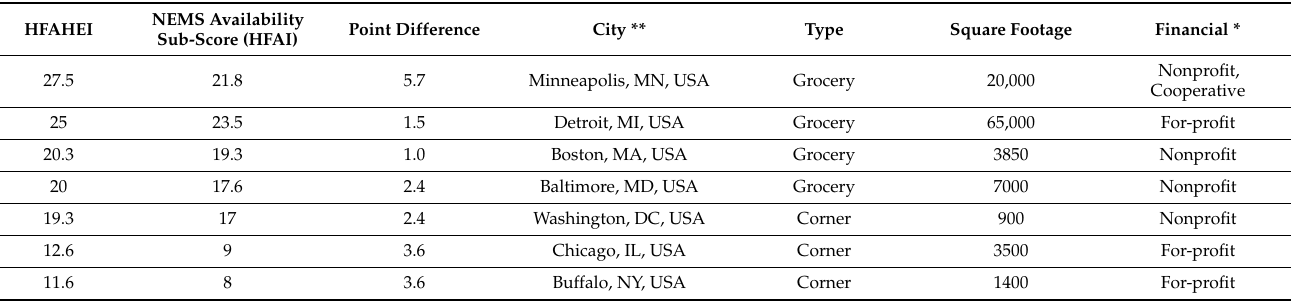
Table 2. HFAHEI (0–30) difference comparison with HFAI ( − 6–25) by store type, square footage, and financial model.